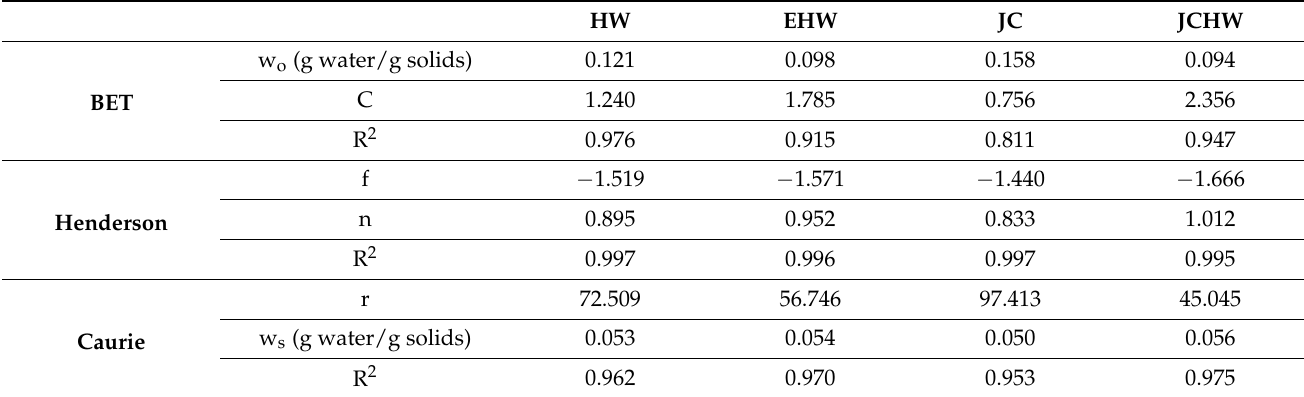
Table 1. Sorption isotherms parameters. HW: hot water; EHW: extrusion + hot water; JC: jet cooker; JCHW: jet cooker + hot water. HW EHW